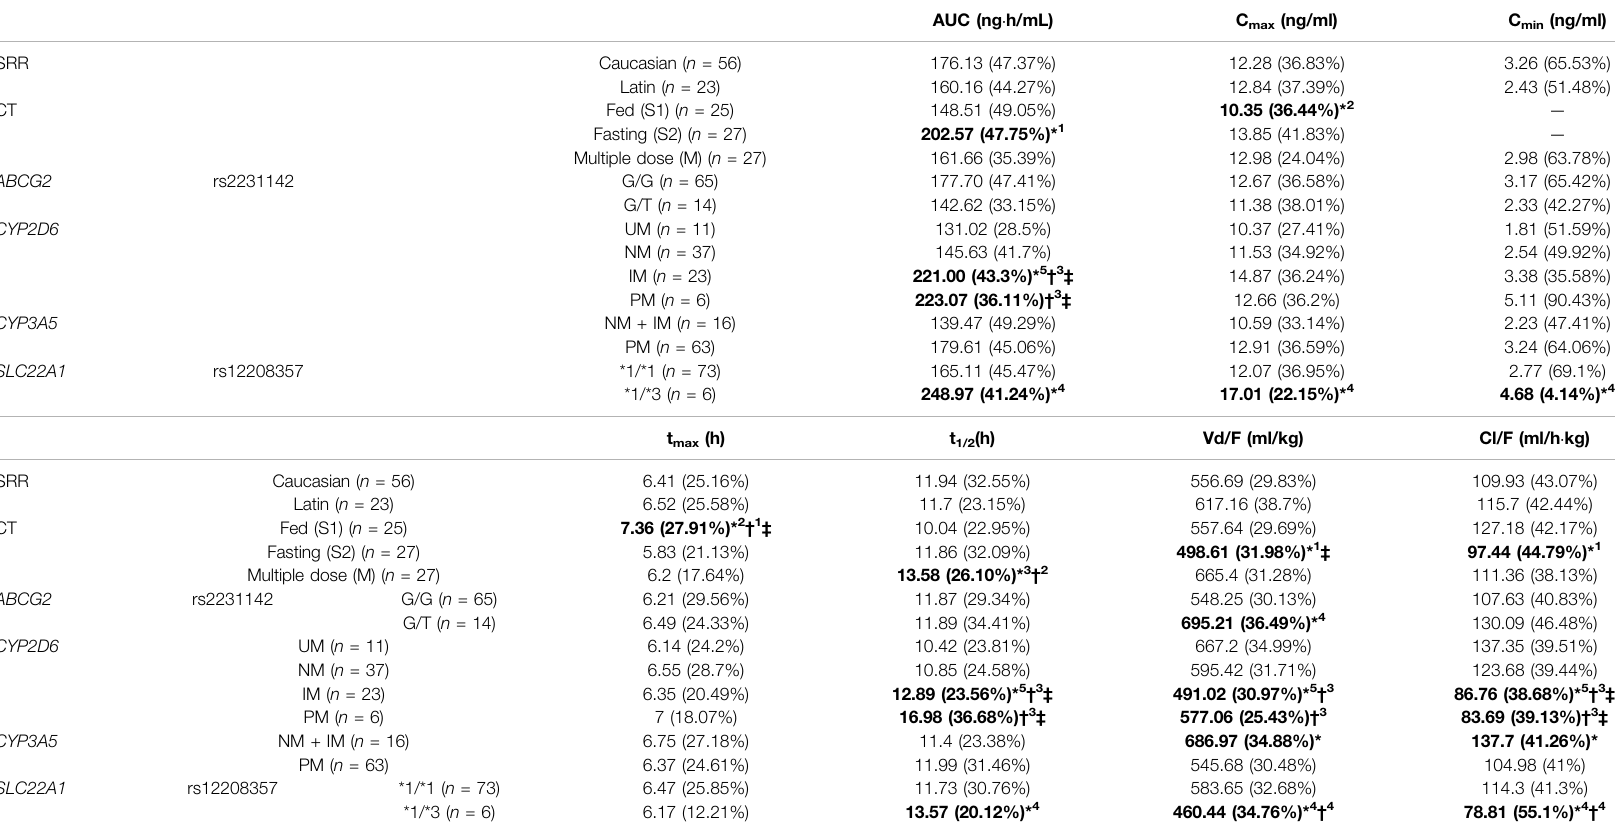
TABLE 2 | Signi fi cant relationships between tamsulosin pharmacokinetics and clinical trial design, volunteers self-reported race and